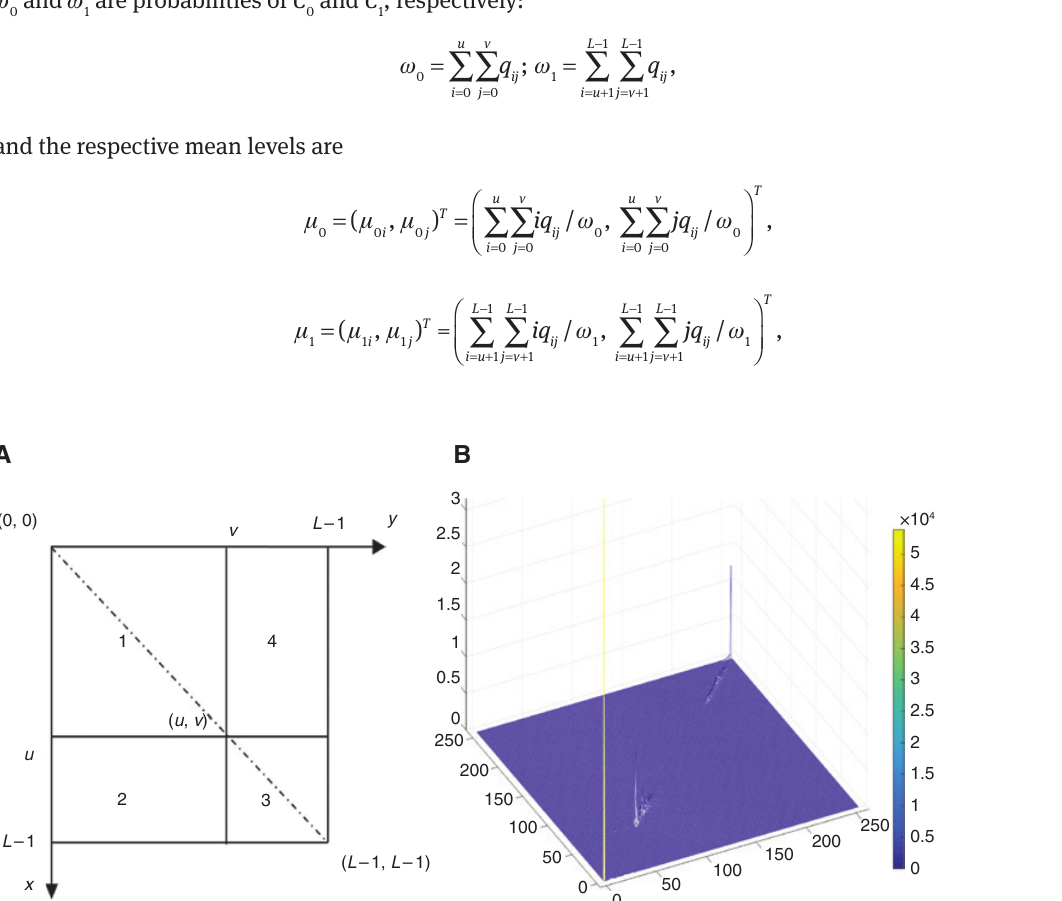
Figure 1: Two-Dimensional Histogram. (A) Projection in the plane x 0 y . (B) 2D histogram of the CT image 3